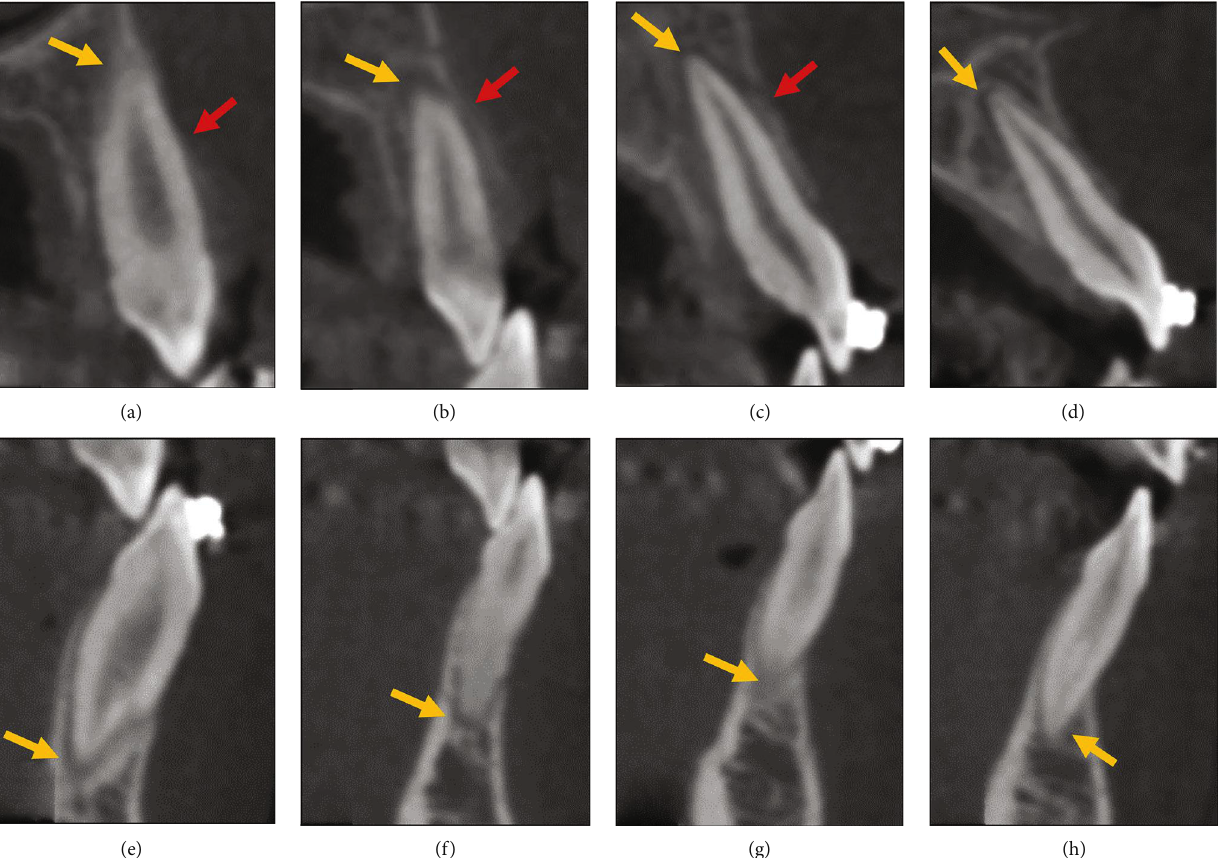
Figure 7: Dental CBCT images of the luxated teeth in the maxilla and mandible. Sagittal sections through the (a) maxillary right canine, (b) maxillary right lateral incisor, (c) maxillary right central incisor, (d) maxillary left central incisor, (e) mandibular right canine, (f) mandibular right lateral incisor, (g) mandibular right central incisor, and (h) mandibular left central incisor are shown. The red arrows indicate the location of a buccal alveolar socket wall fracture. The yellow arrows indicate the regions with an enlarged periodontal ligament